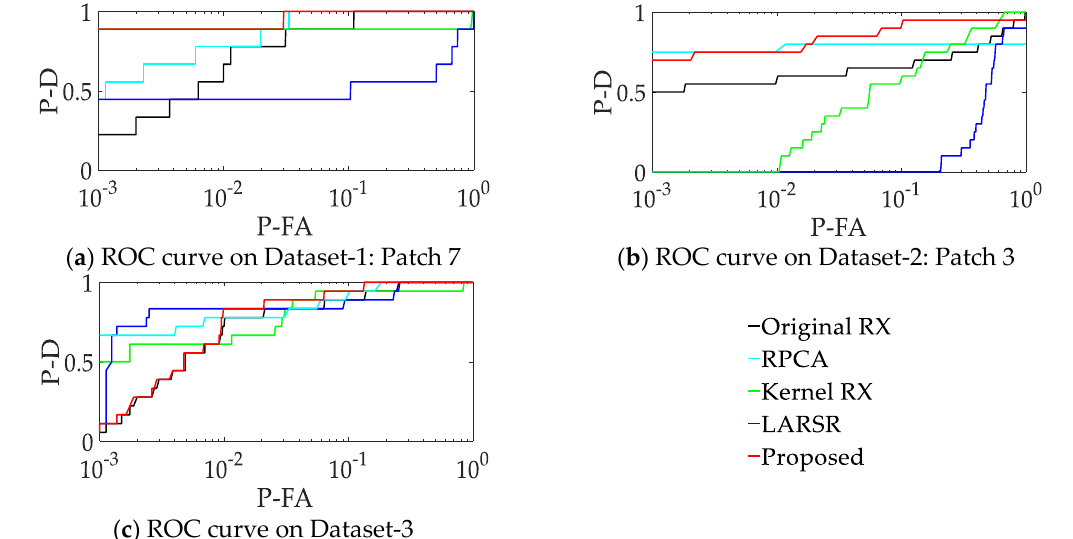
( c ) ROC curve on Dataset-3 Figure 11. Semilog receiver operating characteristic (ROC) curves. Figure 12. Semilog receiver operating characteristic (ROC)